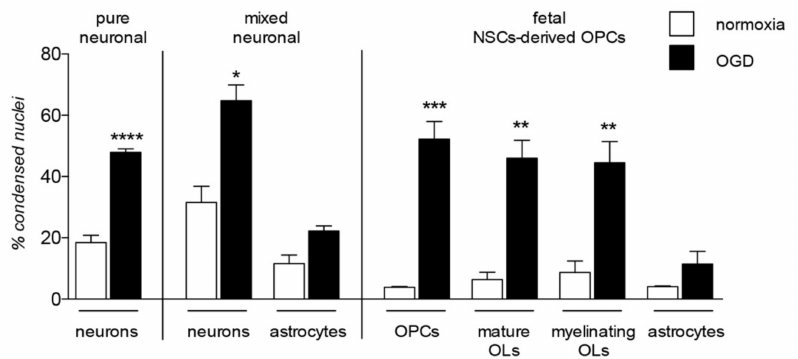
Figure 3. Lineage specific vulnerability to oxygen-glucose deprivation in in vitro models. The graph shows vulnerability to the in vitro model of hypoxia / ischemia, the oxygen-glucose deprivation (OGD), analyzed in three di ff erent in vitro models: pure neuronal, mixed neuronal / astroglial and neural stem cells (NSCs)-derived OPCs cultures. This is a summary chart of already published data [45,46], measured by cell-based high content screening and represented as percentage of condensed nuclei. Statistical analysis has been performed by Student’s t-test and asterisks represent the di ff erences between normoxia and OGD exposed cells of the same lineage (* p < 0.05, ** p < 0.01, *** p =